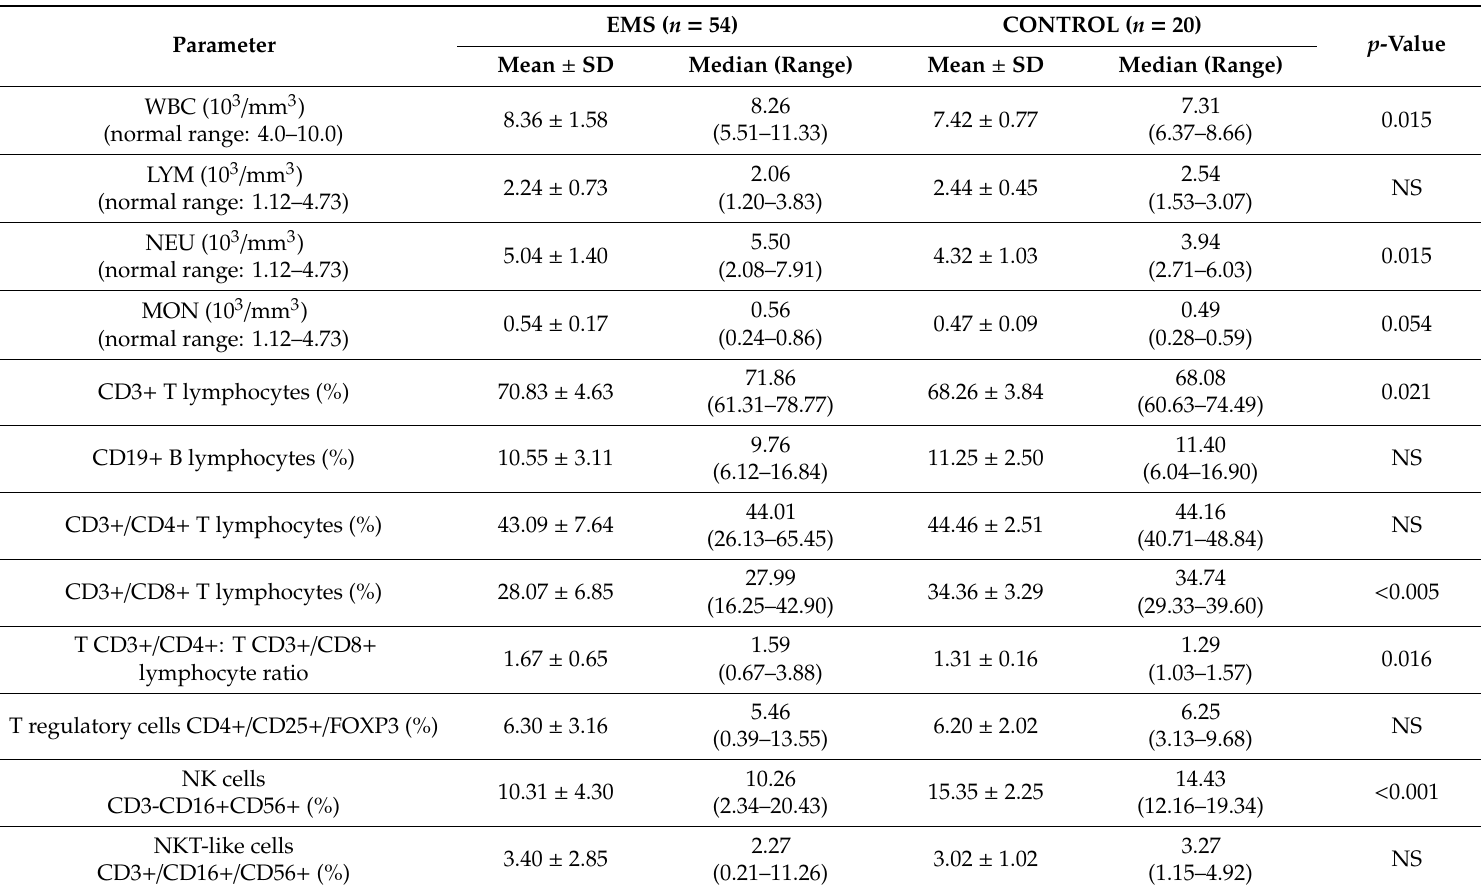
Table 2. White blood cell count and basic lymphocyte subsets in patients with endometriosis (EMS) and